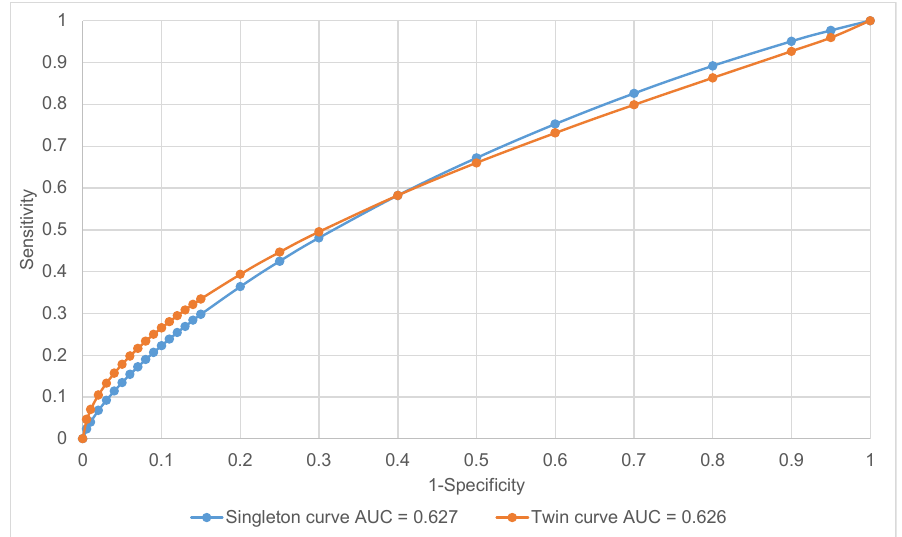
Figure 1. Receiver operating characteristic (ROC) curves—total.